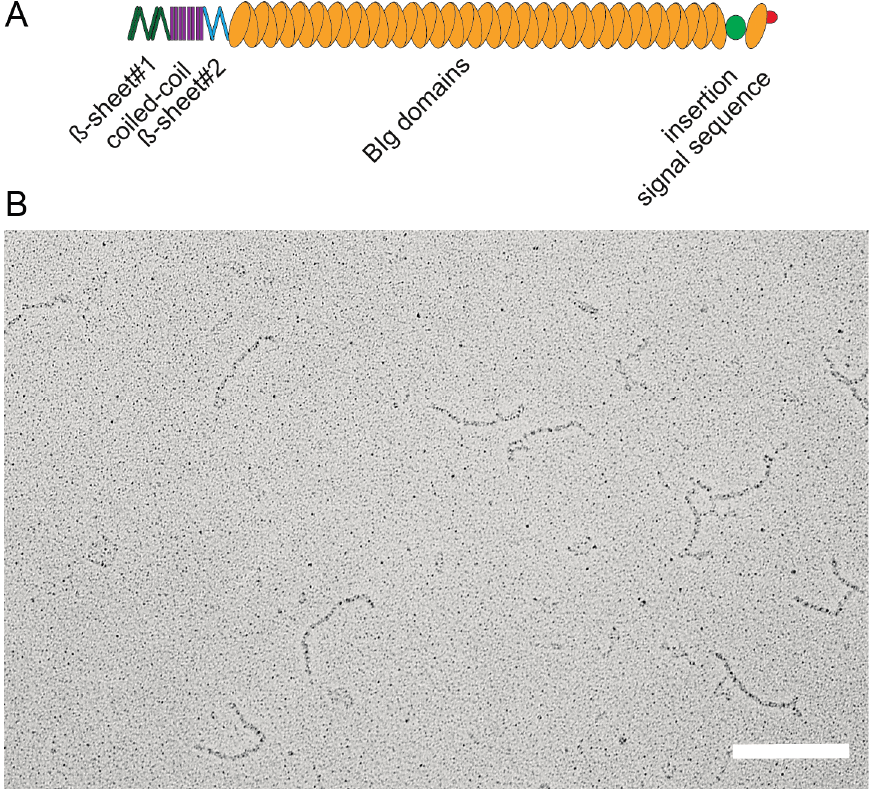
Figure 2. Domain organization and structure of the giant adhesin SiiE. ( A ) Schematic overview of domains within the giant adhesin SiiE. The β -sheet#1, coiled-coil and the β -sheet#2 domains are N-terminally located, followed by 52 bacterial immunoglobulin (BIg) repeats. A 60 amino acid insertion of unknown function is positioned between BIg52 and BIg53. The signal sequence is located to the most C-terminal part; ( B ) Ultrastructure of secreted SiiE. The protein was recovered from the culture supernatant of